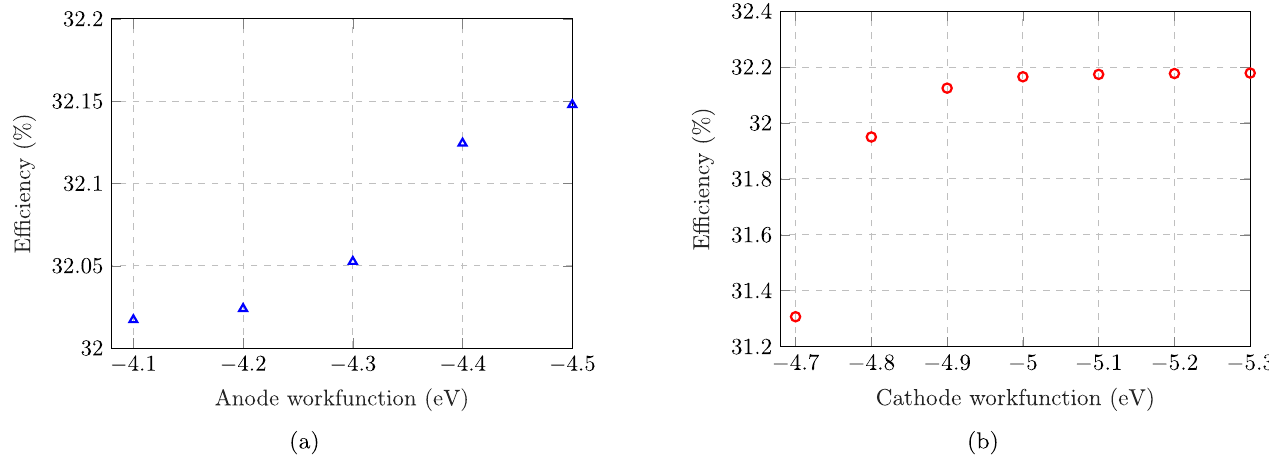
Fig. 14. (a) Tandem cell ef fi ciency as function of bottom cell anode workfunction at a fi xed cathode workfunction of (cid:2) 4.9eV. (b) Tandem cell ef fi ciency as function of bottom cell cathode workfunction at a fi xed anode workfunction of (cid:2) 4.4eV.